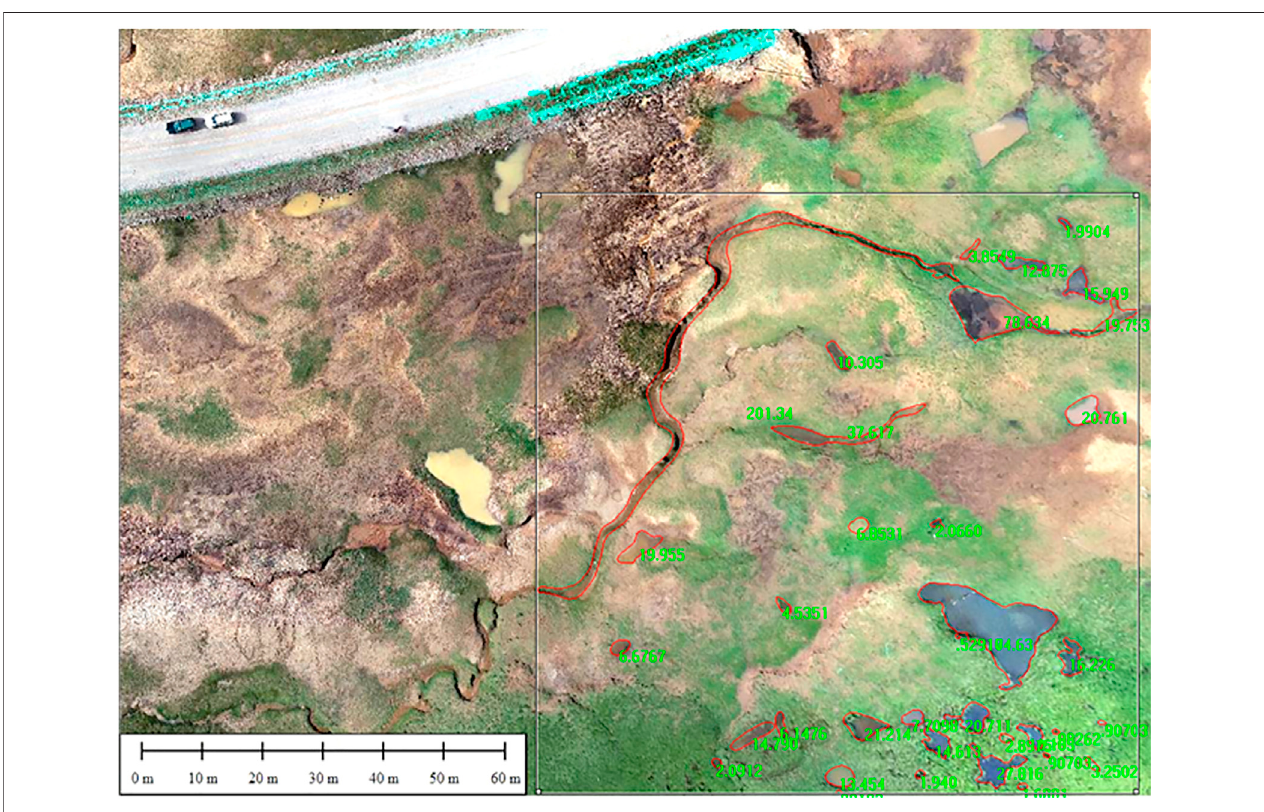
FIGURE 6 | Micro-geomorphological recognition of waterlogged areas.